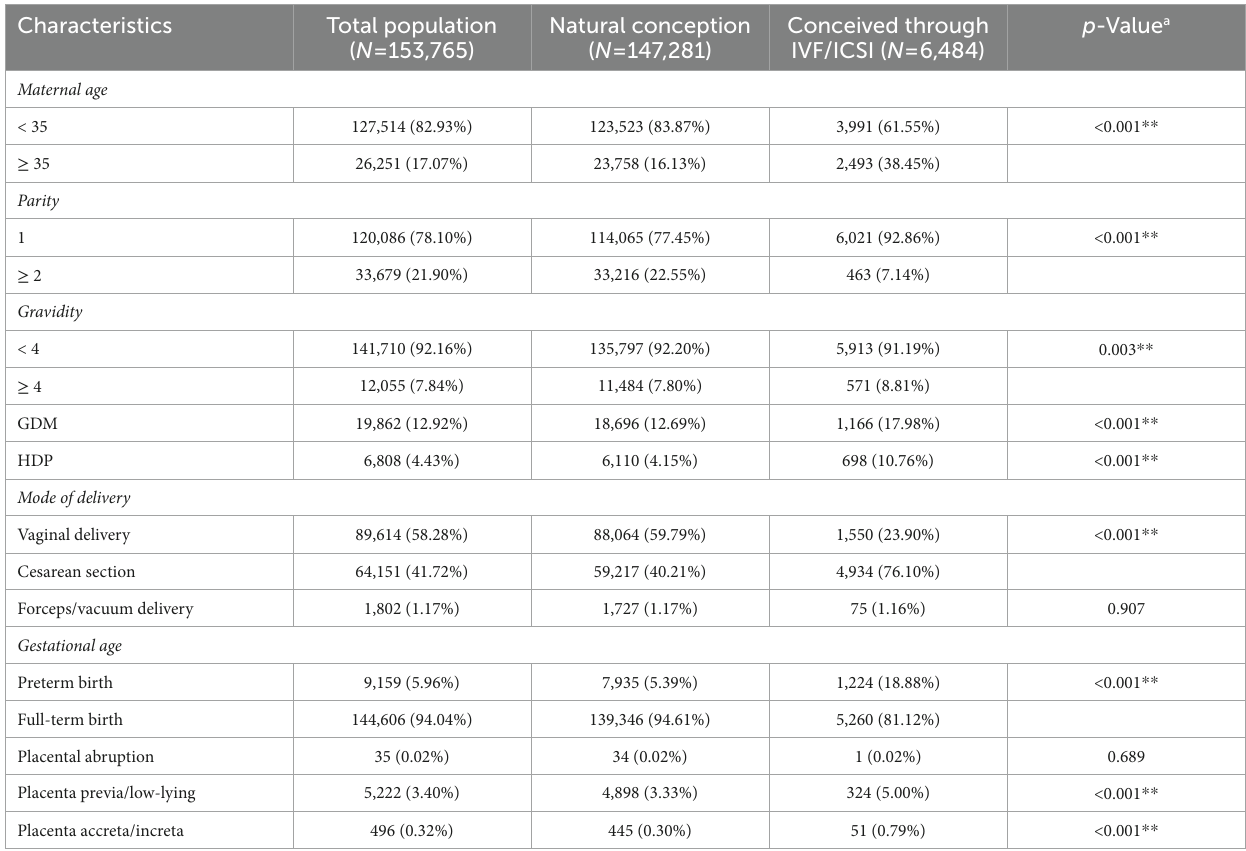
TABLE 1 Individual characteristics of the participants.